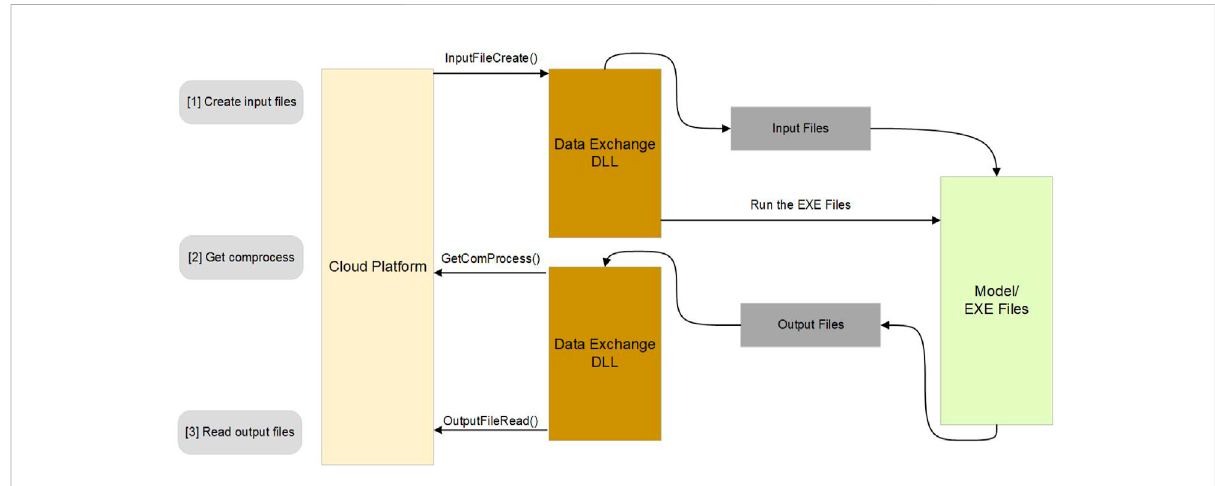
FIGURE 3 Running process of the model in EXE integration